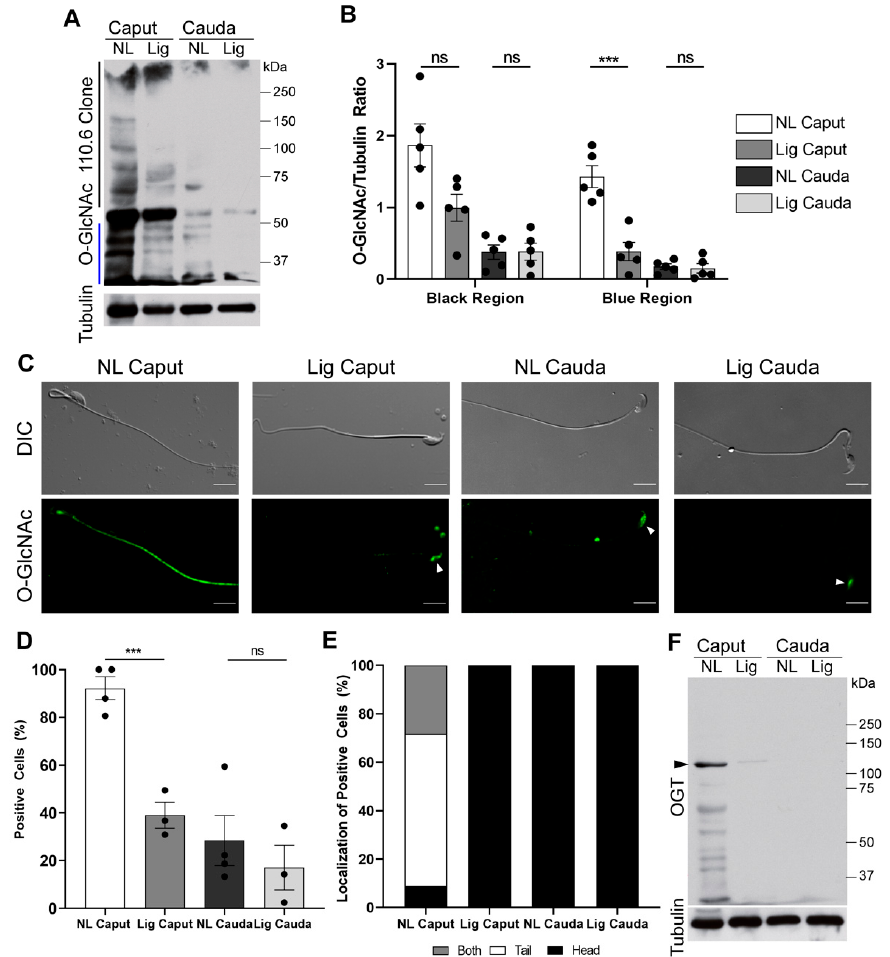
Figure 5. Changes in O-GlcNAcylated proteins after epididymal ligation. Sperm samples were collected from each experimental region 7-days post-ligation surgery. Samples were capacitated for 40 min prior to protein extraction and separation by SDS-PAGE. ( A ) Western blot of O-GlcNAcylated proteins (O-GlcNAc clone 110.6). Membranes were stripped and re-probed with anti β -tubulin as loading control. n = 5. ( B ) Quantification of optical densitometry ratio between O-GlcNAc and β -tubulin. Ratios were taken in two segments: area above 60 kDa (denoted by black line) and below 50 kDa (denoted by blue line). n = 5. ( C ) Localization of O-GlcNAcylated proteins (O-GlcNAc) in sperm by immunofluorescence. Upper panels, DIC microscopy images of sperm collected from NL Caput, Lig Caput, NL Cauda, and Lig Cauda. Lower panel, epifluorescence images of the localization of O-GlcNAc (green) in sperm collected from NL Caput, Lig Caput, NL Cauda, and Lig Cauda. White arrowheads indicate O-GlcNAc signal in the sperm head. Scale bars: 5 µm. n = 4. ( D ) Quantification of O-GlcNAc-positively stained sperm from each epididymal region. ( E ) Quantification of the cellular localization of O-GlcNac from the positively stained O-GlcNAc sperm. Independent experiments n = 4, individual sperm counted: NL Caput = 519, Lig Caput = 334, NL Cauda = 520, Lig Cauda = 520. ( F ) Western blot of O-GlcNAc Transferase (OGT, black arrowhead: 110 kDa). Membranes were stripped and re-probed with anti β -tubulin antibody as loading control. n = 3.